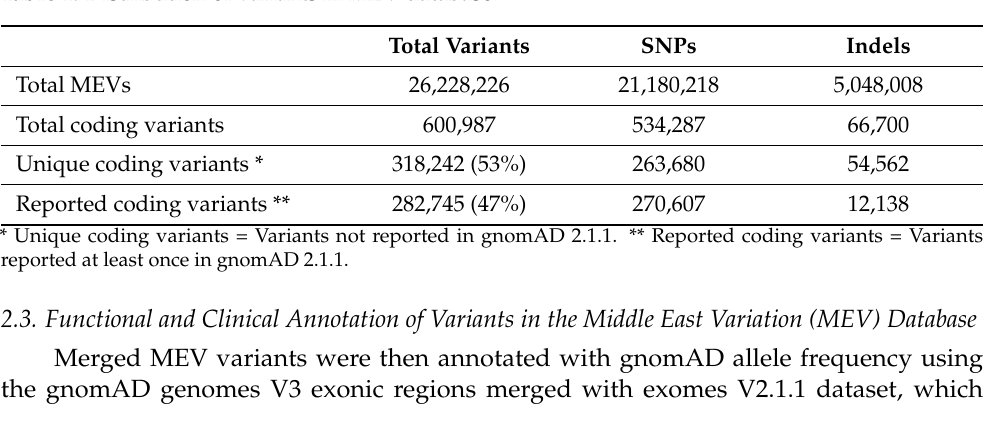
Figure 1. Samples used for this study. ( A ) Data from a total of 88 whole genomes and 2028 whole exomes from the Qatar and Greater Middle East (GME) studies were aggregated in this study; ( B ) ancestry distribution of samples from the Qatar dataset; ( C ) ancestry distribution of samples from the GME dataset. NWA, Northwest Africa; NEA, Northeast Africa; TP, Turkish Peninsula; SD, Syrian Desert; AP, Arabian Peninsula; PP, Persia and Pakistan. Table 1. Distribution of variants in MEV